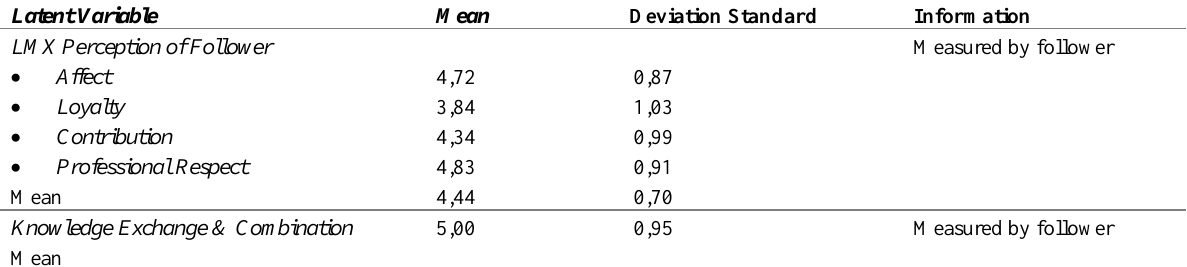
Table 3: Descriptive Statistics Analysis